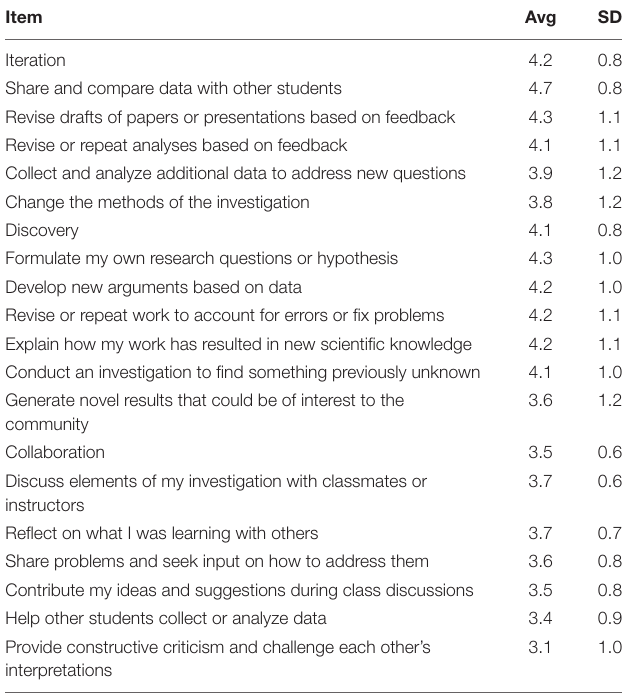
TABLE 6 | Laboratory course assessment